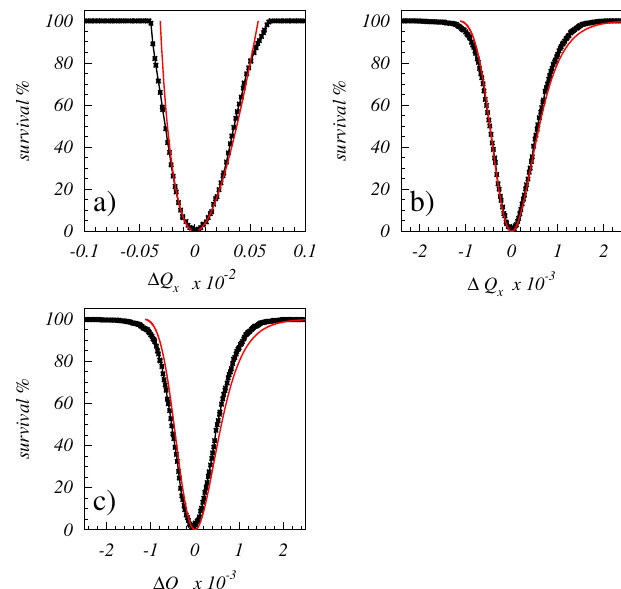
FIG. 22. Case of one sextupole and one octupole: (a) Beam survival for a 1D KV beam distribution as a function of (cid:1) Q x (black), and theoretical prediction (red). (b) Beam survival for a 1D Gaussian beam distribution as a function of (cid:1) Q x (black), and theoretical prediction (red). (c) Beam survival for a 2D Gaussian beam distribution as a function of (cid:1) Q x (black), and theoretical prediction